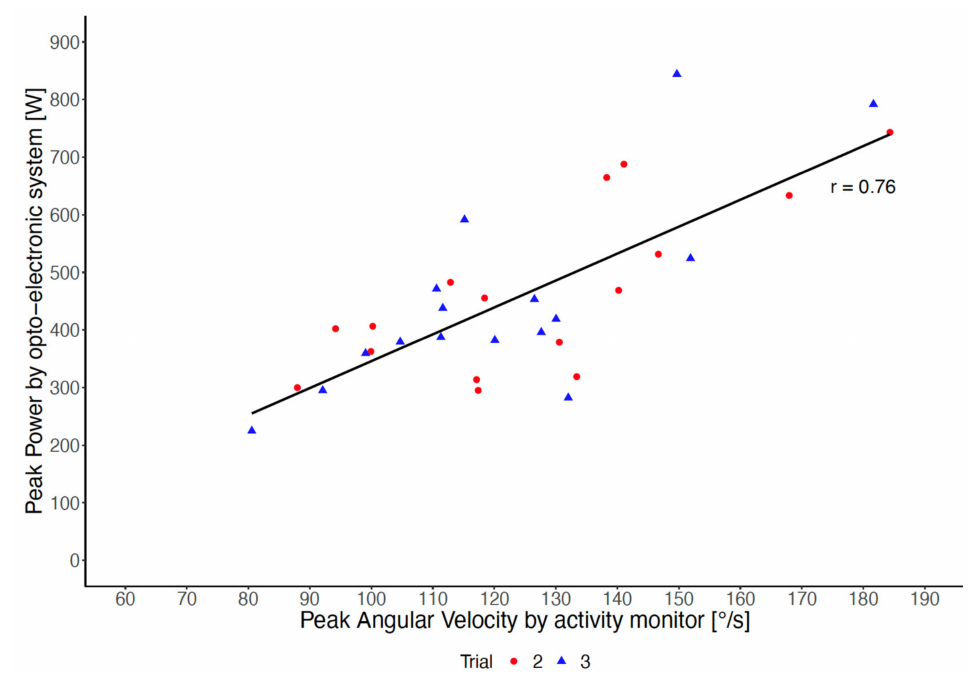
Figure 3. Association between peak angular velocity measured by the thigh-worn activity monitor and peak power measured by the opto-electronic system according to Trials 2 and